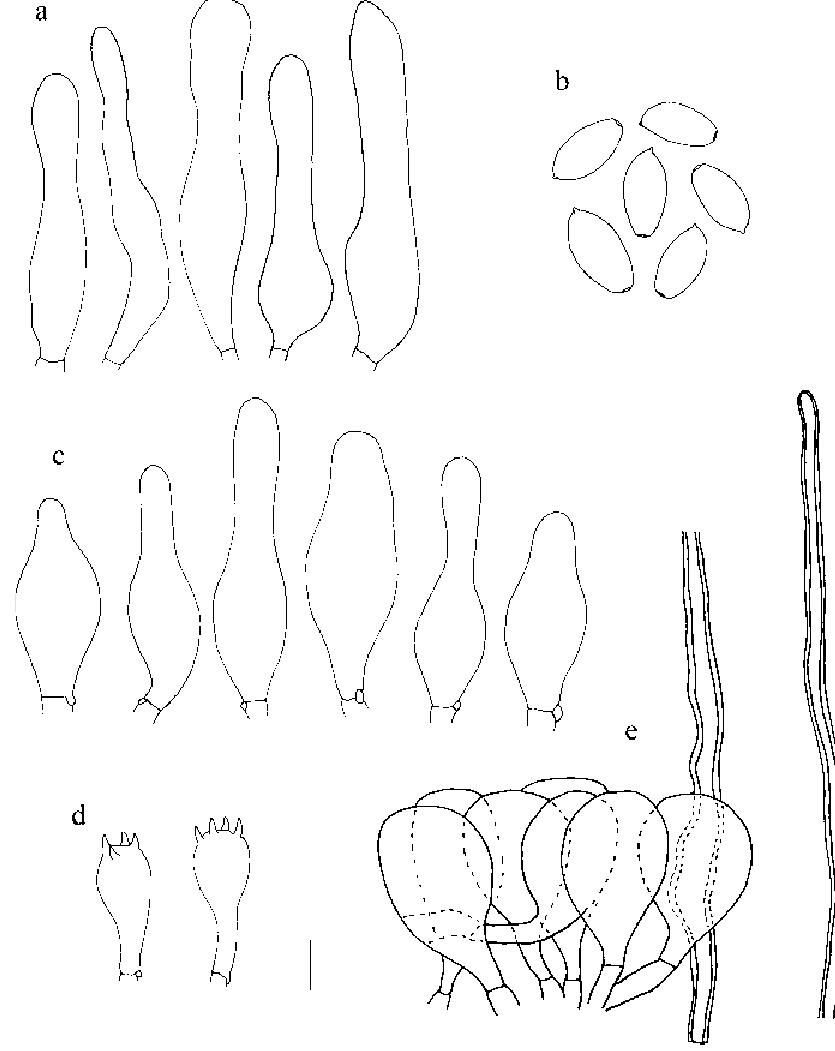
Fig. 1. Psathyrella conopilus (Fr.: Fr.) A. Pear son et Dennis, coll. kRAM F-54148; a – caulocystidia, b – spores, c – cheilocystidia, d – basidia, e – pileipellis; scale bar = 10